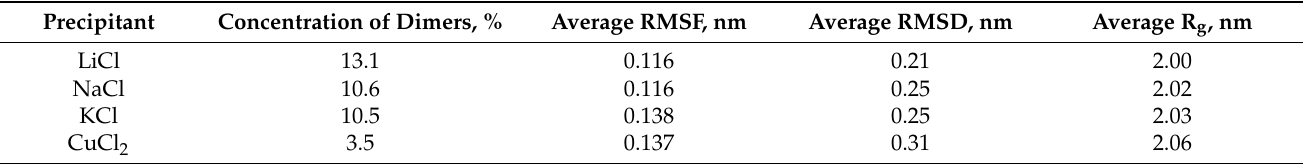
Figure 1. RMSF of dimers with different precipitants: LiCl, NaCl, KCl and CuCl 2 . Chains A and B are the polypeptide chains of dimers. Table 1. Comparison of concentration, RMSF, RMSD and radius of gyration of dimers averaged over 3 simulations and over all C α atoms. Given concentration data are obtained from SAXS measurements [10].